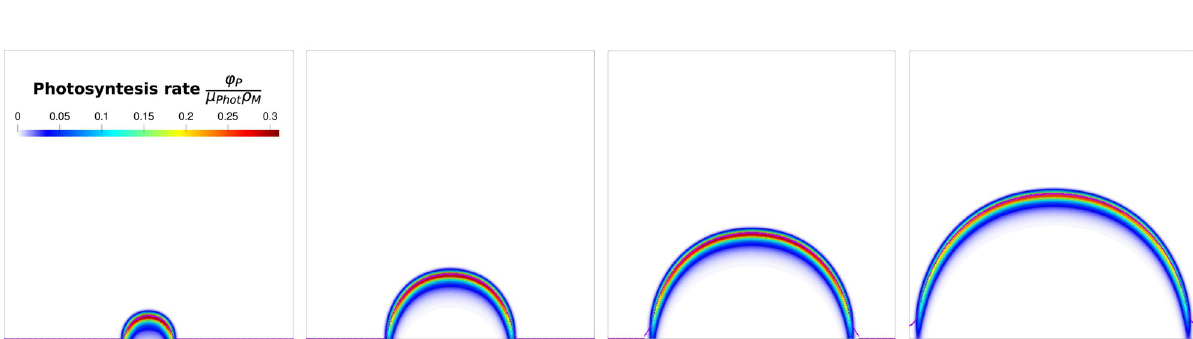
Fig 4. Photosynthesis rate in the biofilm ( φ Phot , see S2 Text for the detailed mathematical expression) at times t = 5, t = 15, t = 25 and t = 35 days for a biofilm starting from a single spot colony. The purple dotted line represents the biofilm front.